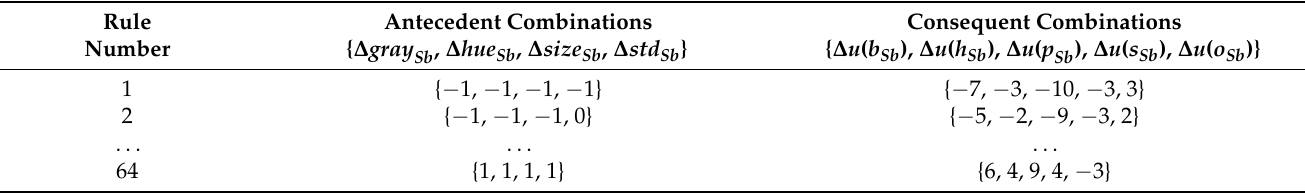
Table 9. Rule base of reagent compensation for antimony rougher